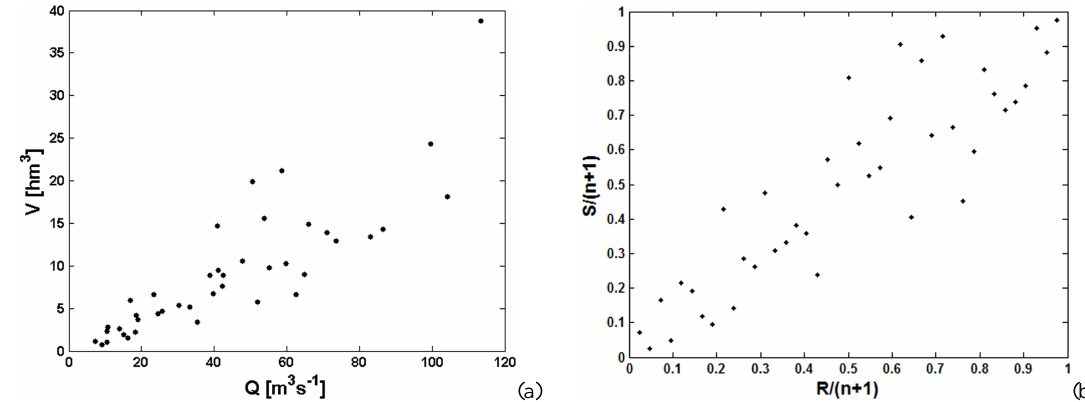
Fig. 3. Scatter plot. (a) Observed data ( Q i , V i ). (b) Ranks ( R i /( n + 1), S i /( n + 1)) derived from the observed data.